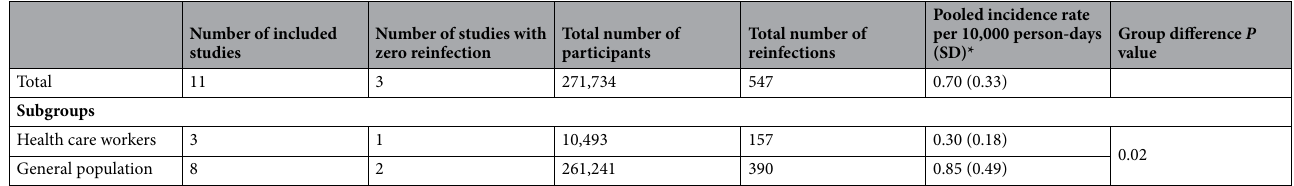
Table 3. Pooled incidence rate of reinfection and subgroup analysis. SD standard deviation.